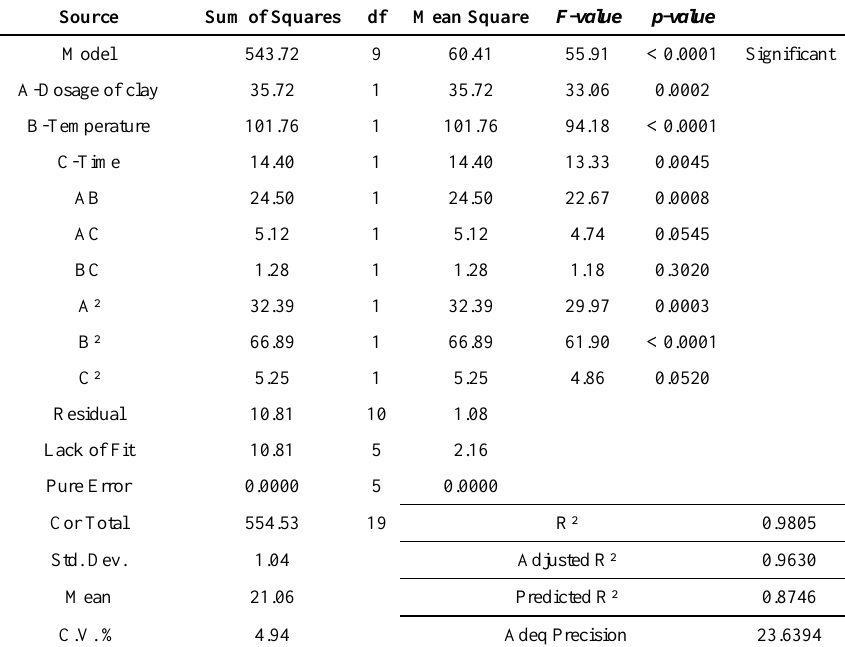
Table 7. ANOVA results of viscosity of